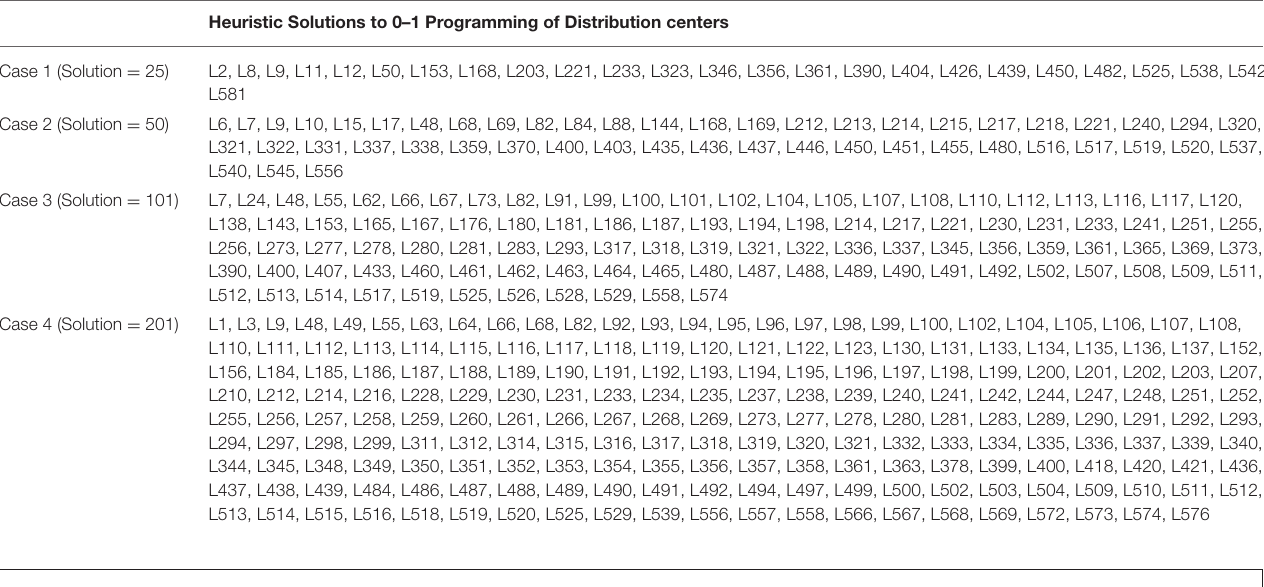
TABLE 3 | Heuristic Solutions to 0–1 Programming for Locations of Distribution centers Serving Cross-border E-business in Beijing. Heuristic Solutions to 0–1 Programming of Distribution centers